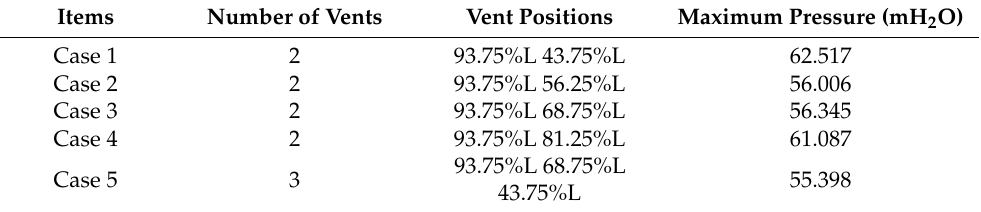
Table 4. Maximum pressure in the tailrace tunnel with different numbers of vents.